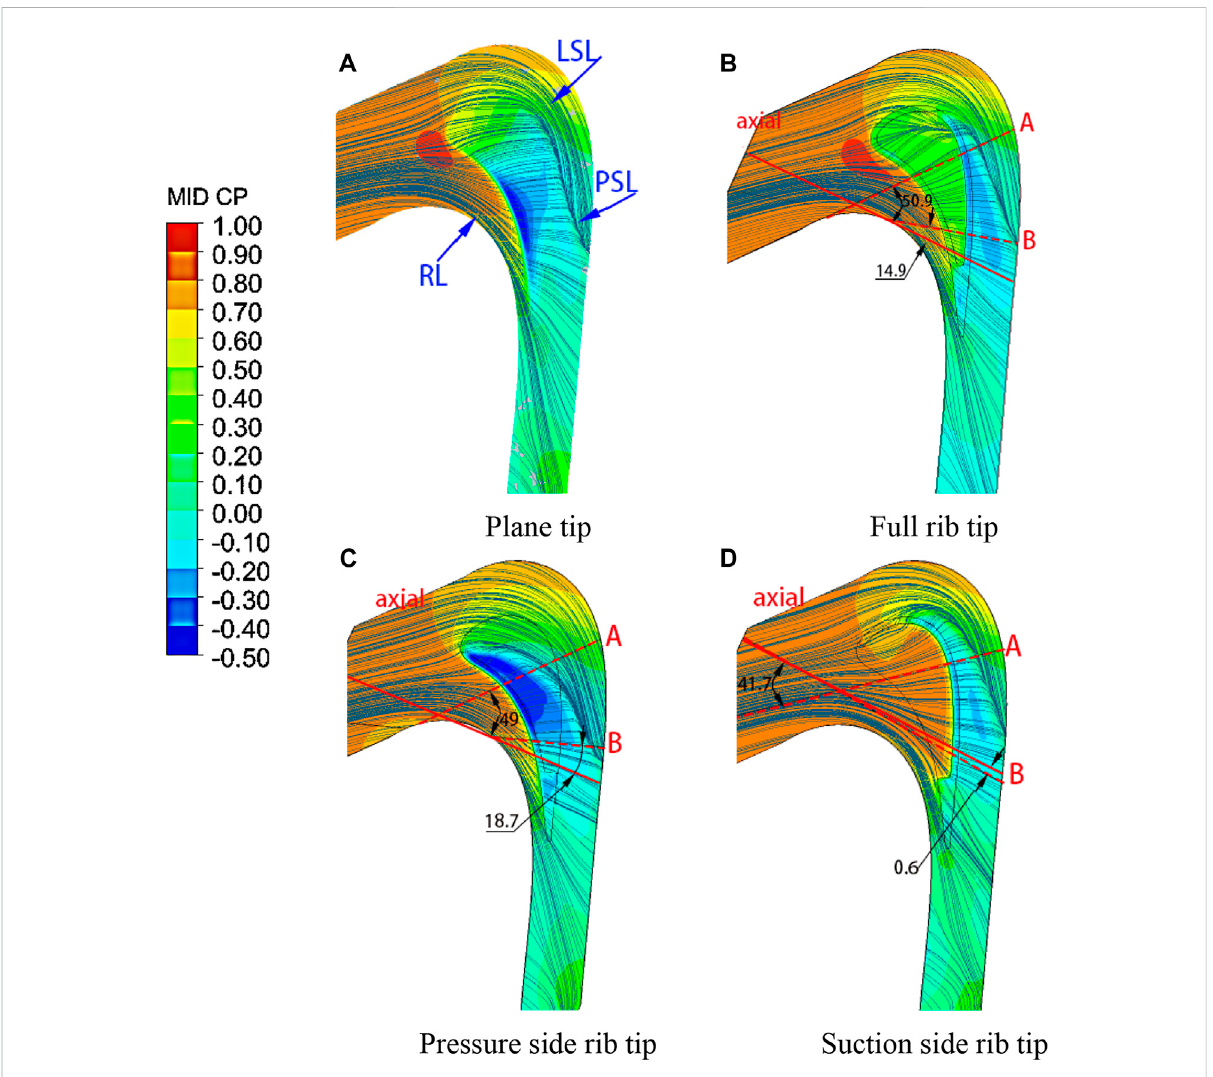
FIGURE 7 Flow line and end wall static pressure distribution in the middle section of blade tip clearance. (A) Plane tip. (B) Full rib tip. (C) Pressure-side rib tip. (D) Suction-side rib